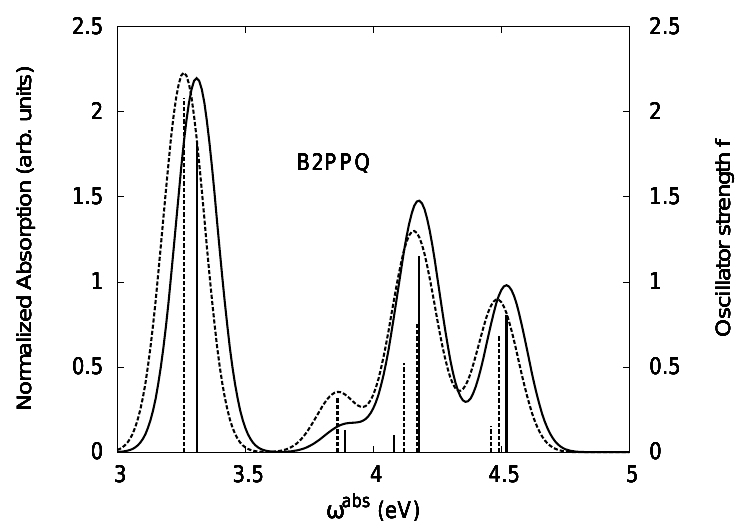
Figure 5. The same as Figure 2, but for